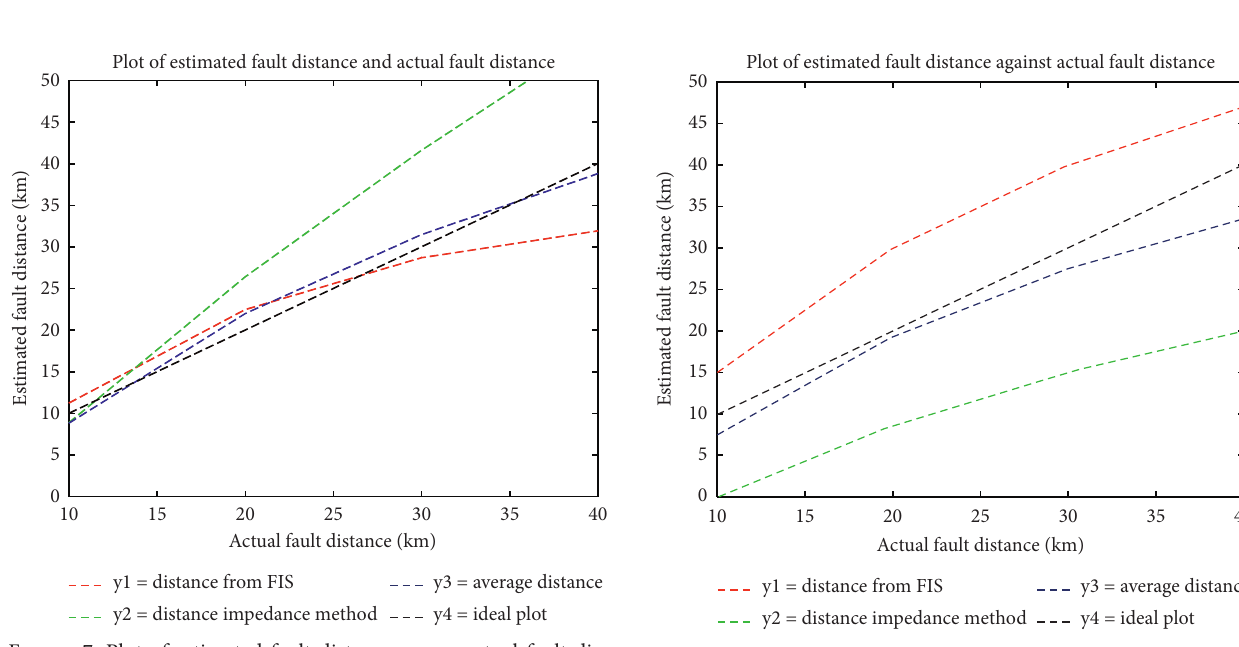
Figure 8: Plot of estimated fault distance versus actual fault dis- tance for underground distribution